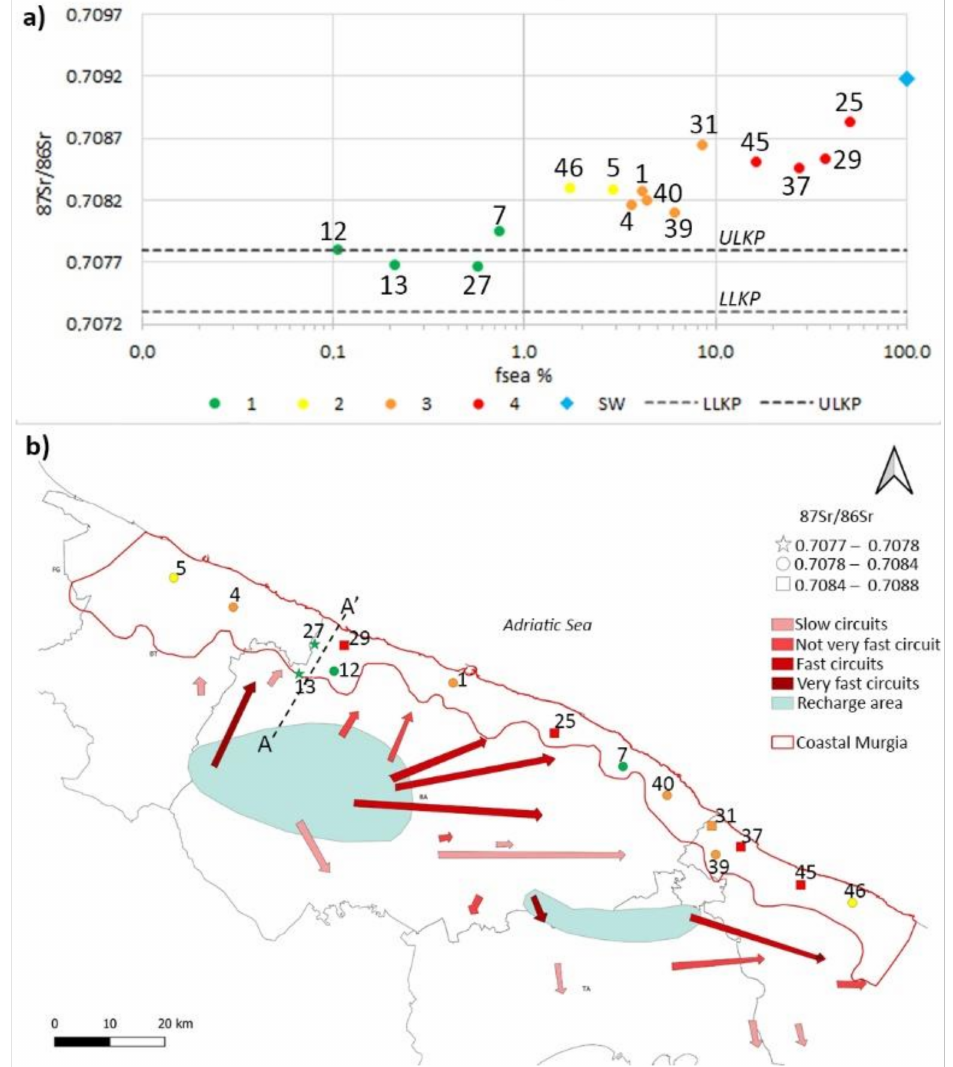
Figure 5. ( a ) 87 Sr/ 86 Sr ratio vs f sea % observed in the MWs of the Coastal Murgia. Different dots represent different groundwater groups: green (1) groundwater with Cl − < 250 mg/L, yellow (2) groundwater with 250 ≤ Cl − < 700 mg/L, orange (3) groundwater with 700 mg/L ≤ Cl − < 3000 mg/L, red (4) groundwater with Cl − ≥ 3000 mg/L. The light blue diamond represents the value of the current seawater. ULKP = upper limit of the Cretaceous platform, LLKP = lower limit of the Cretaceous platform.; ( b ) map of 87 Sr/ 86 Sr ratio observed in the MWs. Symbol colours are the same as above defined. Different shapes (stars, dots, and squares) represent different ranges of 87 Sr/ 86 Sr values. Arrows and recharge areas modified from Tulipano et al. [41]. The dashed black line represents the representative transect A-A’ chosen for